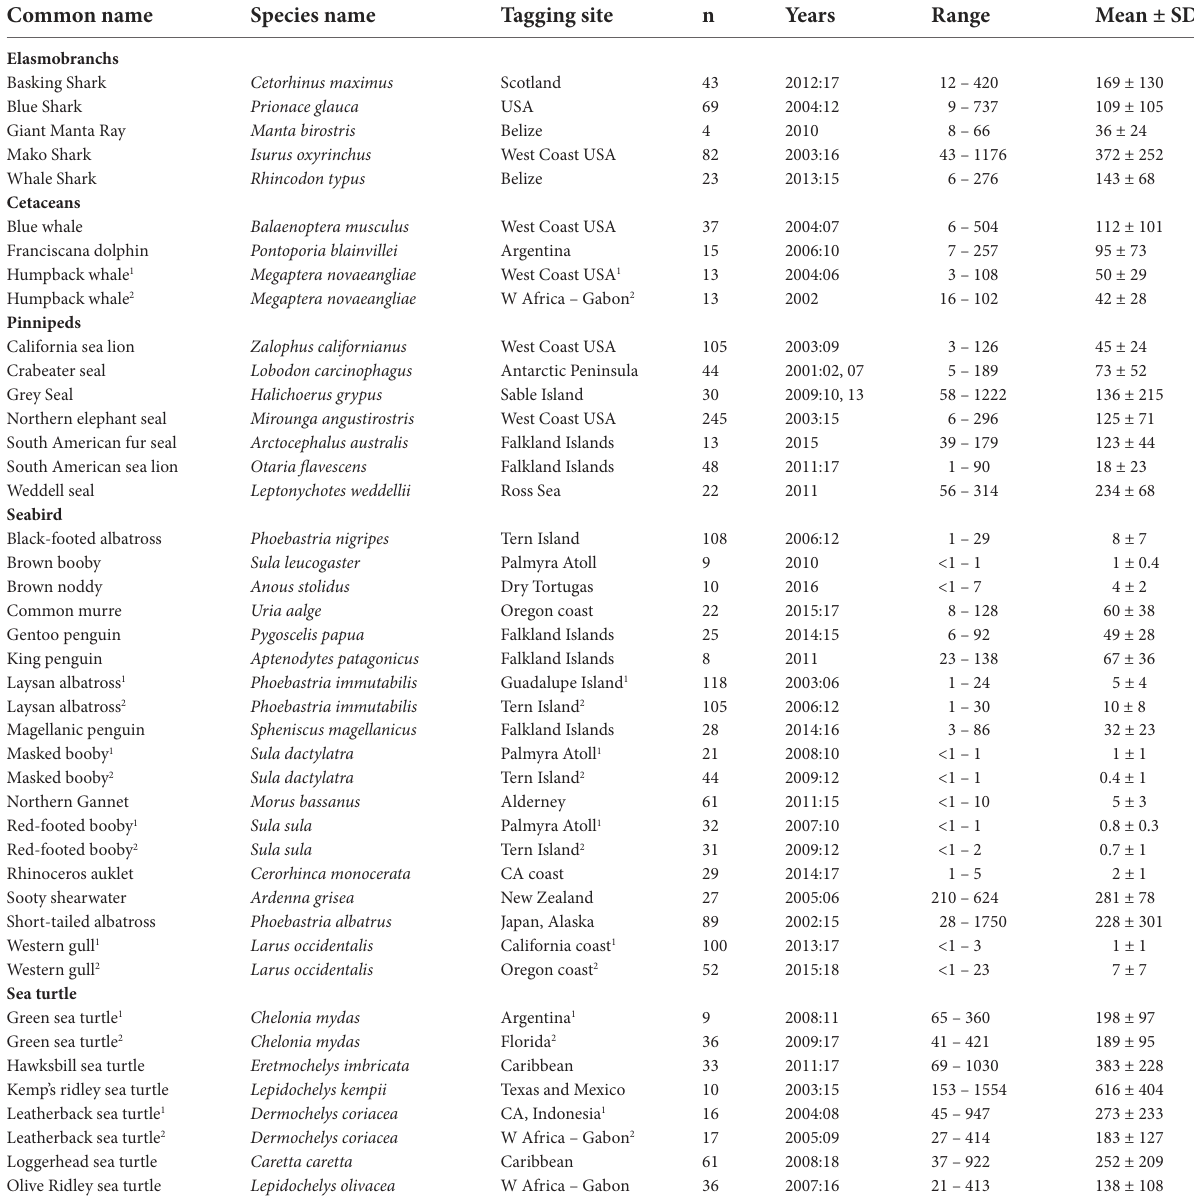
TABLE 1 Overview of 43 tracking datasets from 36 marine megafauna